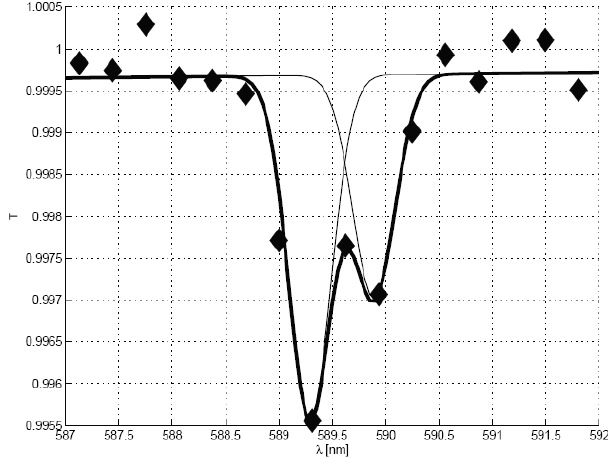
Fig. 47. Diamonds: the median transmittance (of 1121 occultations) measured between 70°N and 80°N during Jan 2003. Thin full lines: individual D2 and D1 absorptions, assumed to have the same instrumental line spread function. Thick line: best fit for the total transmittance (with baseline removed) (from Fussen et al., 2010).